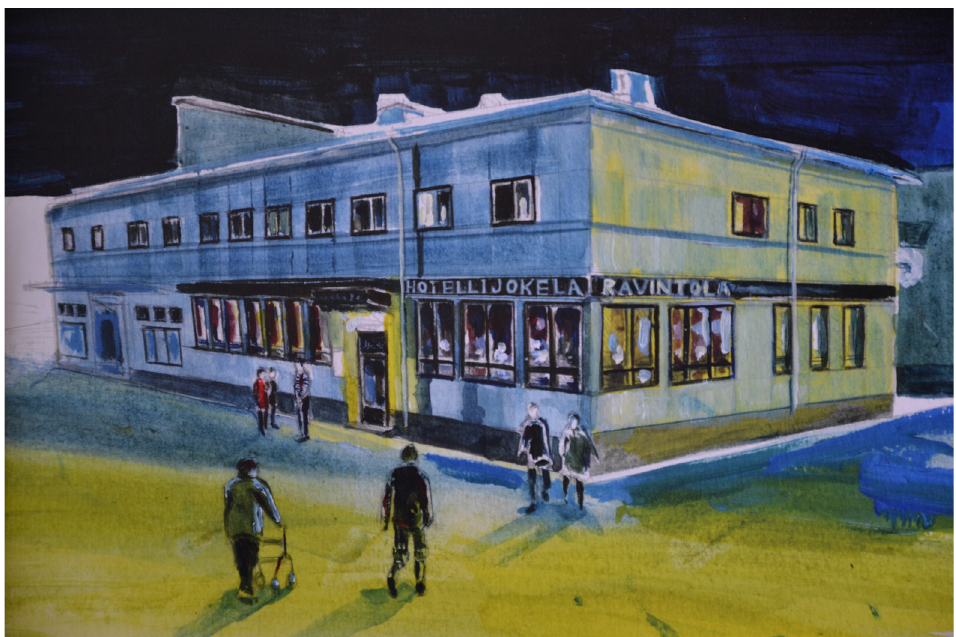
Fig. 1. The Wanha Jokela Restaurant building, closed since 2012, returns to the agenda in 2018 – as an issue of detailed planning. The painting by Heli Kemiläinen decorates the cover of the album Turha kylä ilman Jokelaa (Pilfink Records 2011). The album contains 17 songs by Finnish musicians supporting the restaurant. Copyright Anita